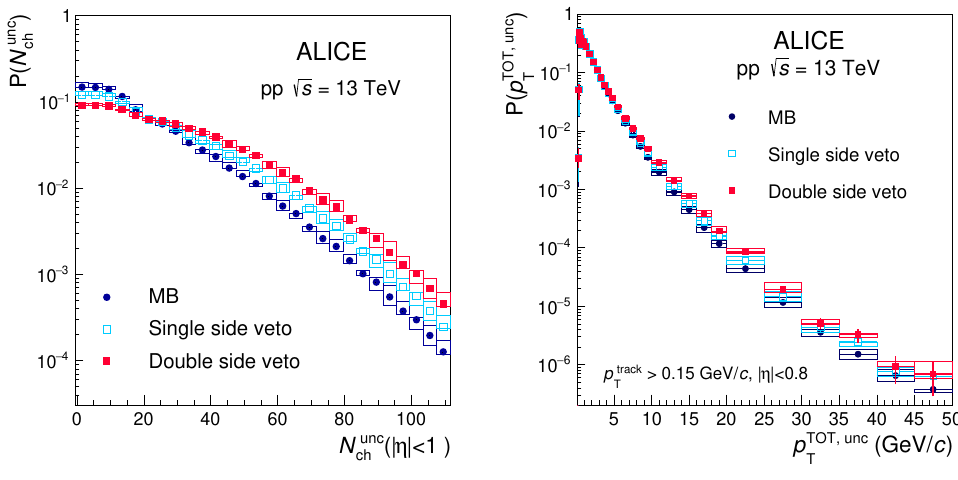
Figure 10 . Distributions of the (not fully corrected) number of charged particles in | η | < 1 (left) and of the total transverse momentum in | η | < 0 . 8 (right) for MB interactions (blue circles), single-side (azure empty squares) and double-side (red full squares) veto conditions on leading baryon production √ in pp collisions at s = 13 TeV.